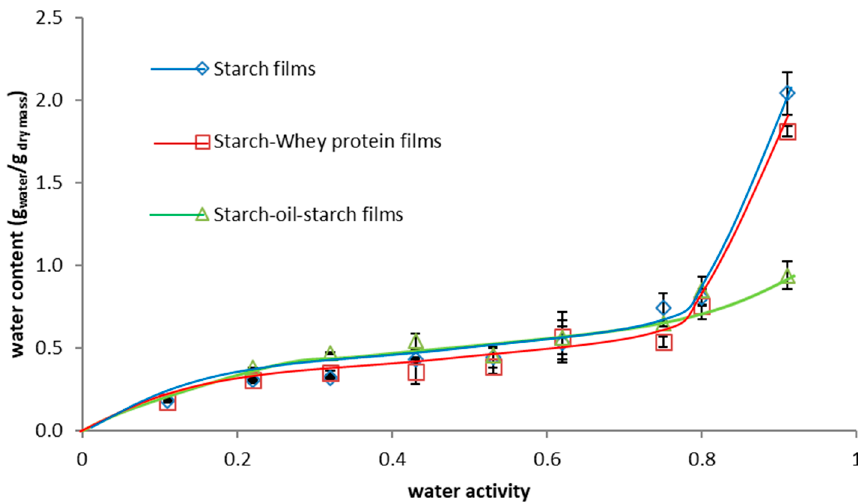
Figure 2. Moisture sorption isotherm of starch films, of starch- whey protein (80/20) films, and of starch-oil-starch 3-layer films (g water /g dry matter ).